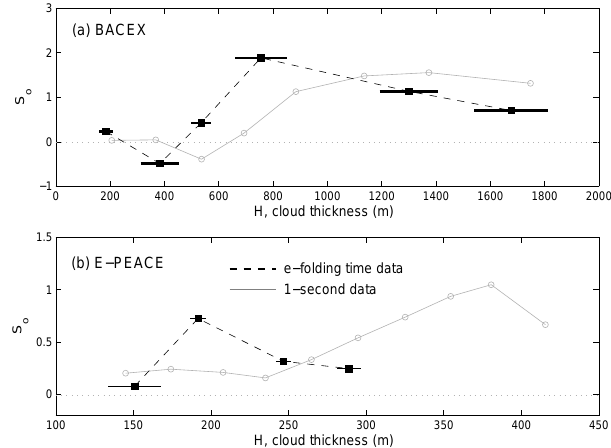
Figure 5. S o estimated with aircraft measurements for (a) BACEX (Cu) and (b) E-PEACE (Sc). The 1s data of individual flights are reduced by averaging over the e -folding time of N d for each flight prior to the